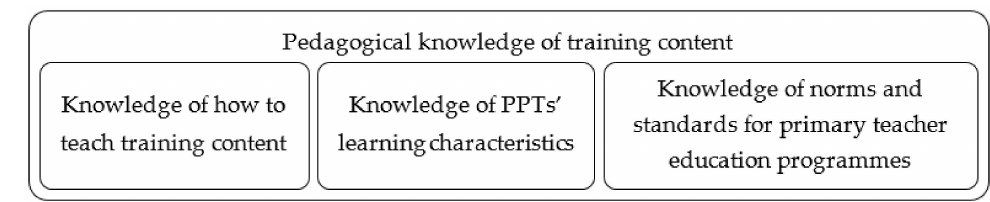
Figure 3. Structure of teacher educators’ pedagogical